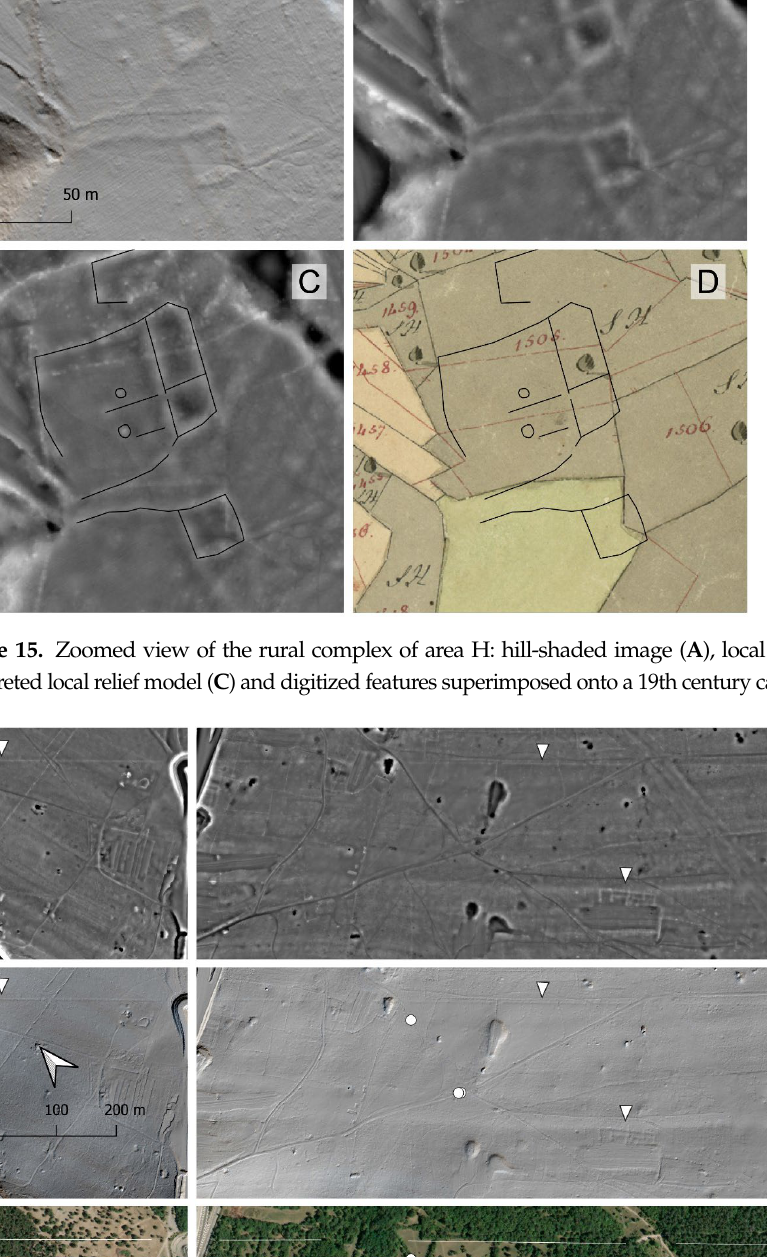
Figure 17. The rural complex of area I with the boundary walls indicated by white arrows and black lines (pictures ( A ) and ( B )) and compared with the Roman centuriation grid of the Karst (dotted